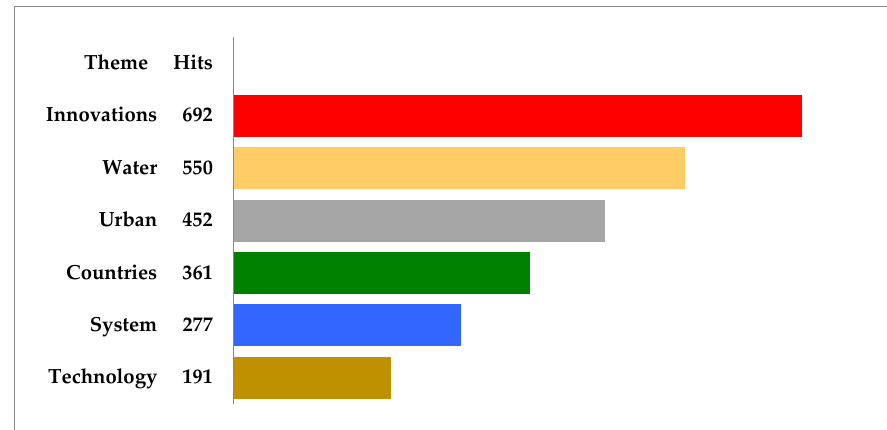
Figure 7. Themes identified by Leximancer.